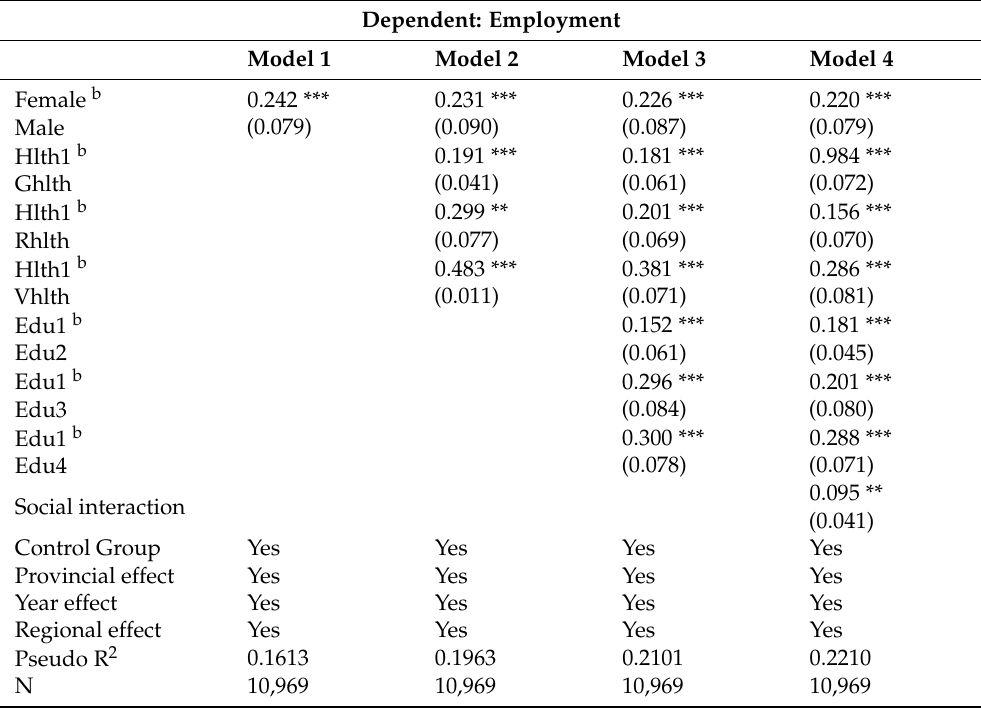
Table 3. Logit regression on employment return to human capital, CGSS 2013 and 2015. Dependent: